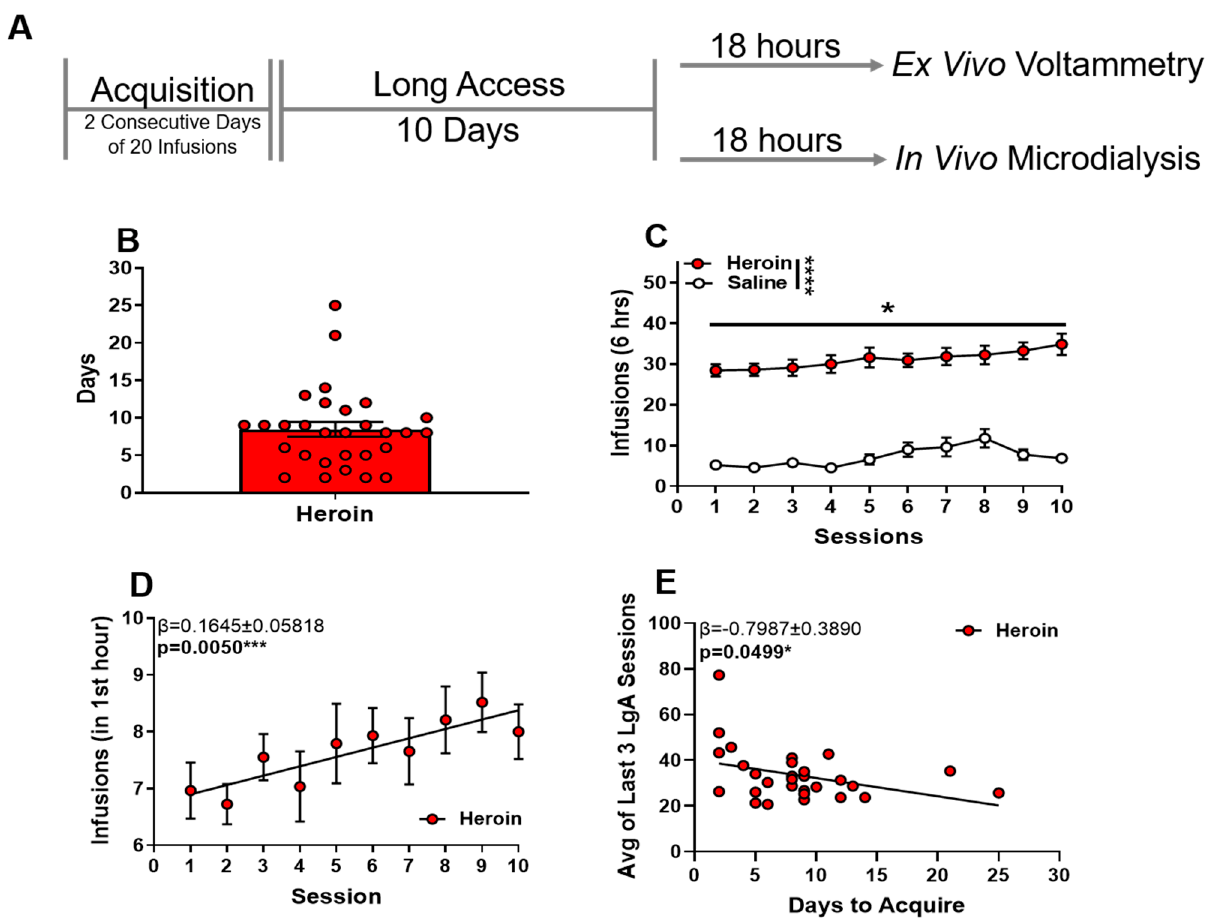
Figure 1. Long access heroin self-administration leads to escalation of heroin intake. ( A ) Experimental timeline of behavioral paradigm. ( B ) The total number of days to reach acquisition criteria. ( C ) Heroin intake during 6-h long access sessions. ( D ) Heroin intake during the first hour of each session. ( E ) Correlation between the number of days to acquisition and average infusions across the last 3 days of heroin long access self-administration. * p < 0.05; *** p < 0.001; **** p < 0.0001.